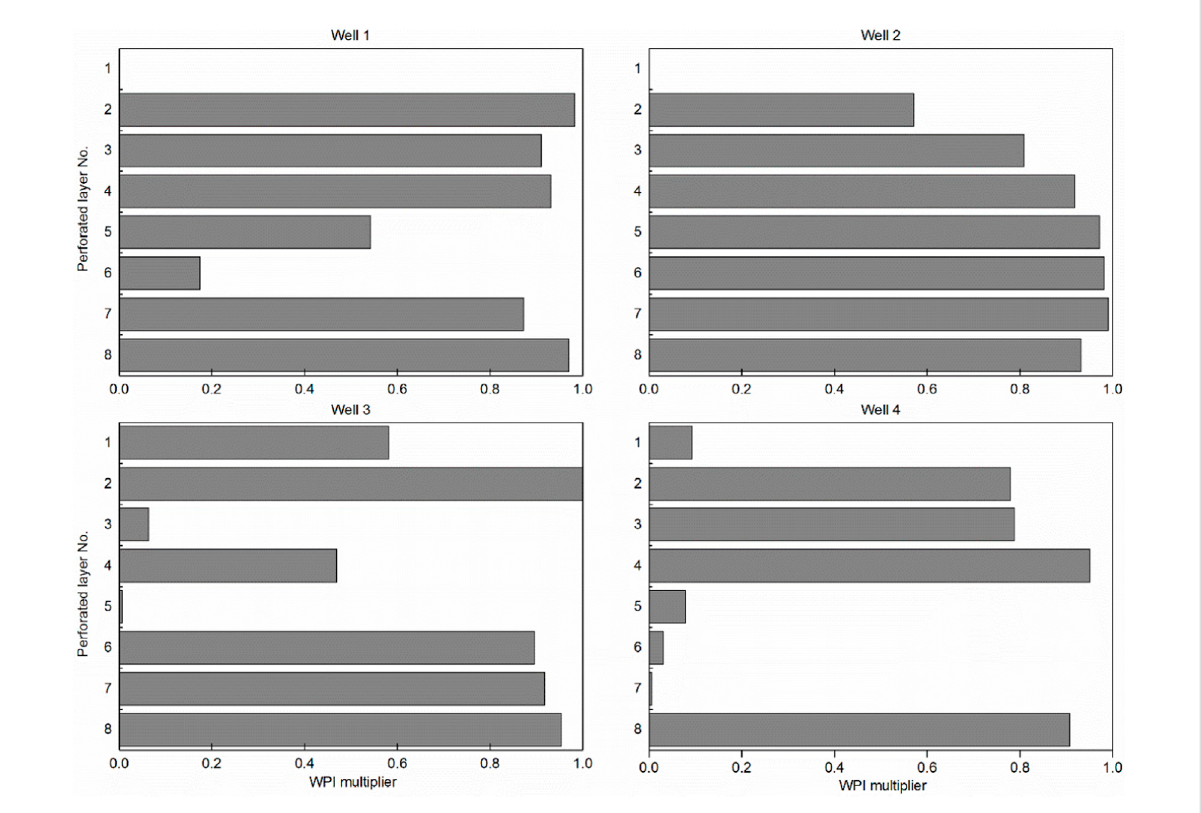
FIGURE 15 WPI multipliers for perforations of the four in fi ll wells, Case